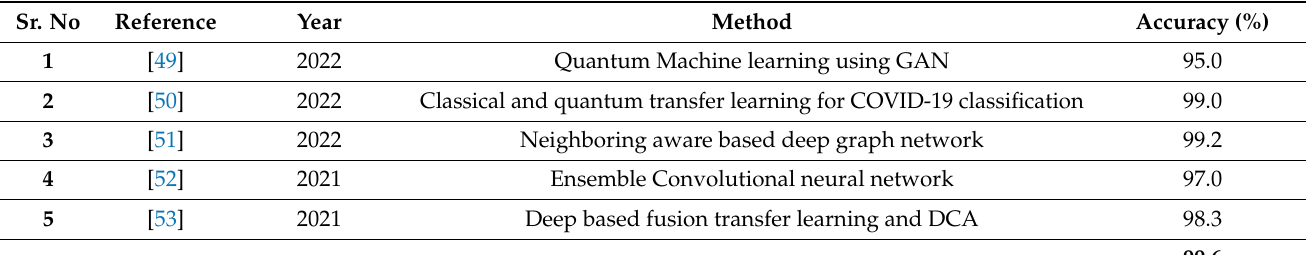
Table 14. Analysis of original CCA-based features fusion and ICCA-based fusion.